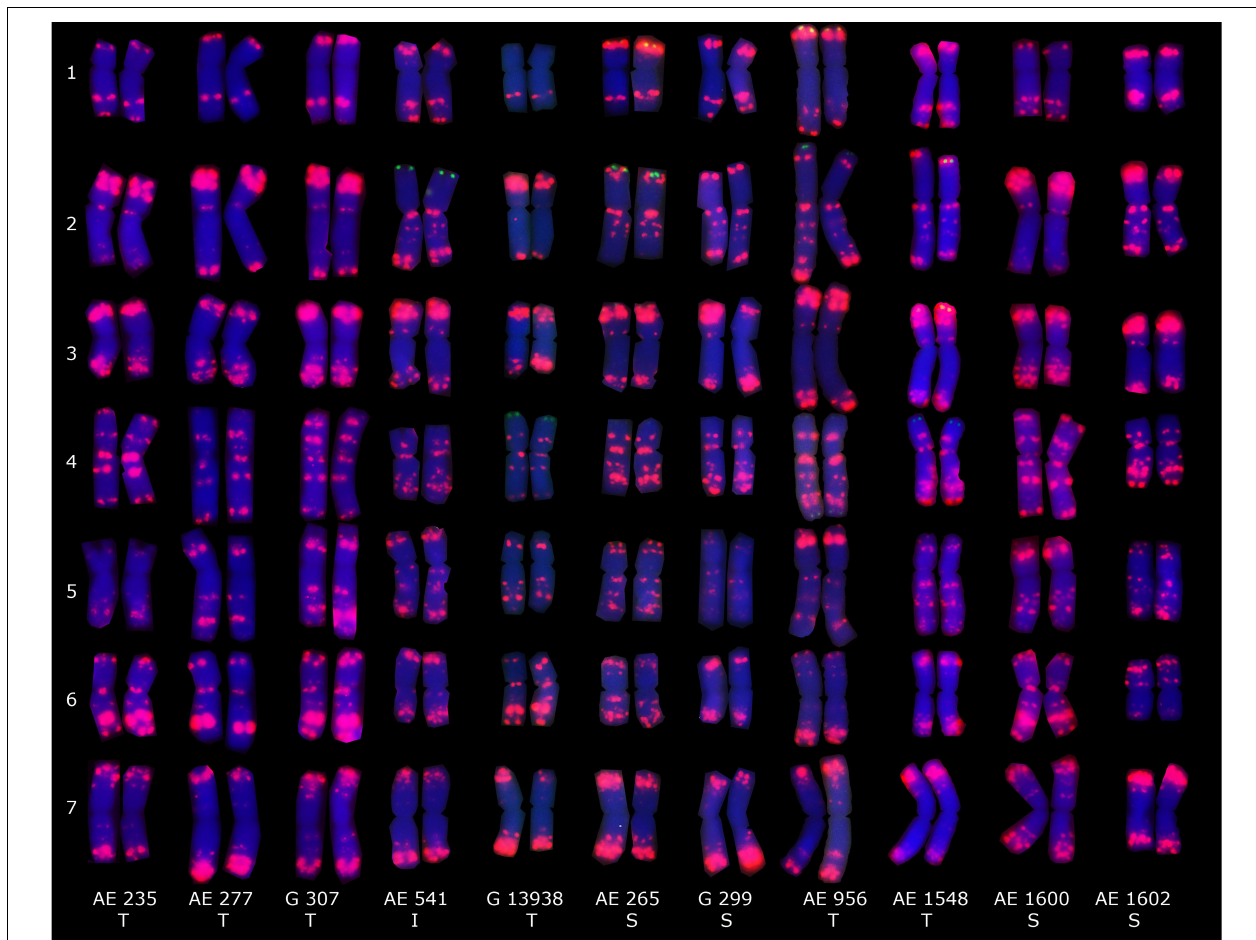
FIGURE 5 | Distribution patterns of pAs1-1 (red) and oligo-pSc119.2-1 probes (green) on the mitotic metaphase chromosomes of eleven Ae. tauschii accessions. Spike morphologies of S, T, and I refers to as subsp. strangulata , subsp. tauschii , and intermediate form,